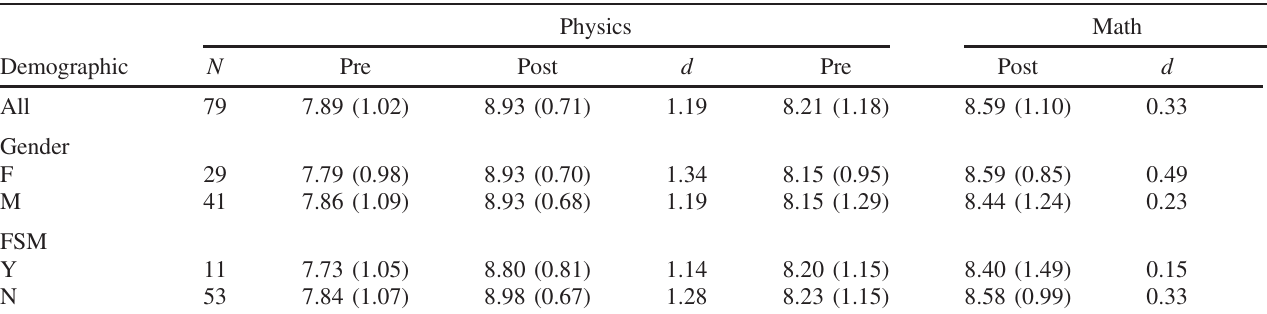
TABLE VI. Self-efficacy pre- and postsurvey ratings for each of the demographics and by topic. The marks shown are the mean self- efficacy rating per statement for that topic, and are out of 11. We display the mean, standard deviation of the sample in brackets, and the Cohen ’ s d between pre- and post-test scores. N indicates the number of students in each sample.